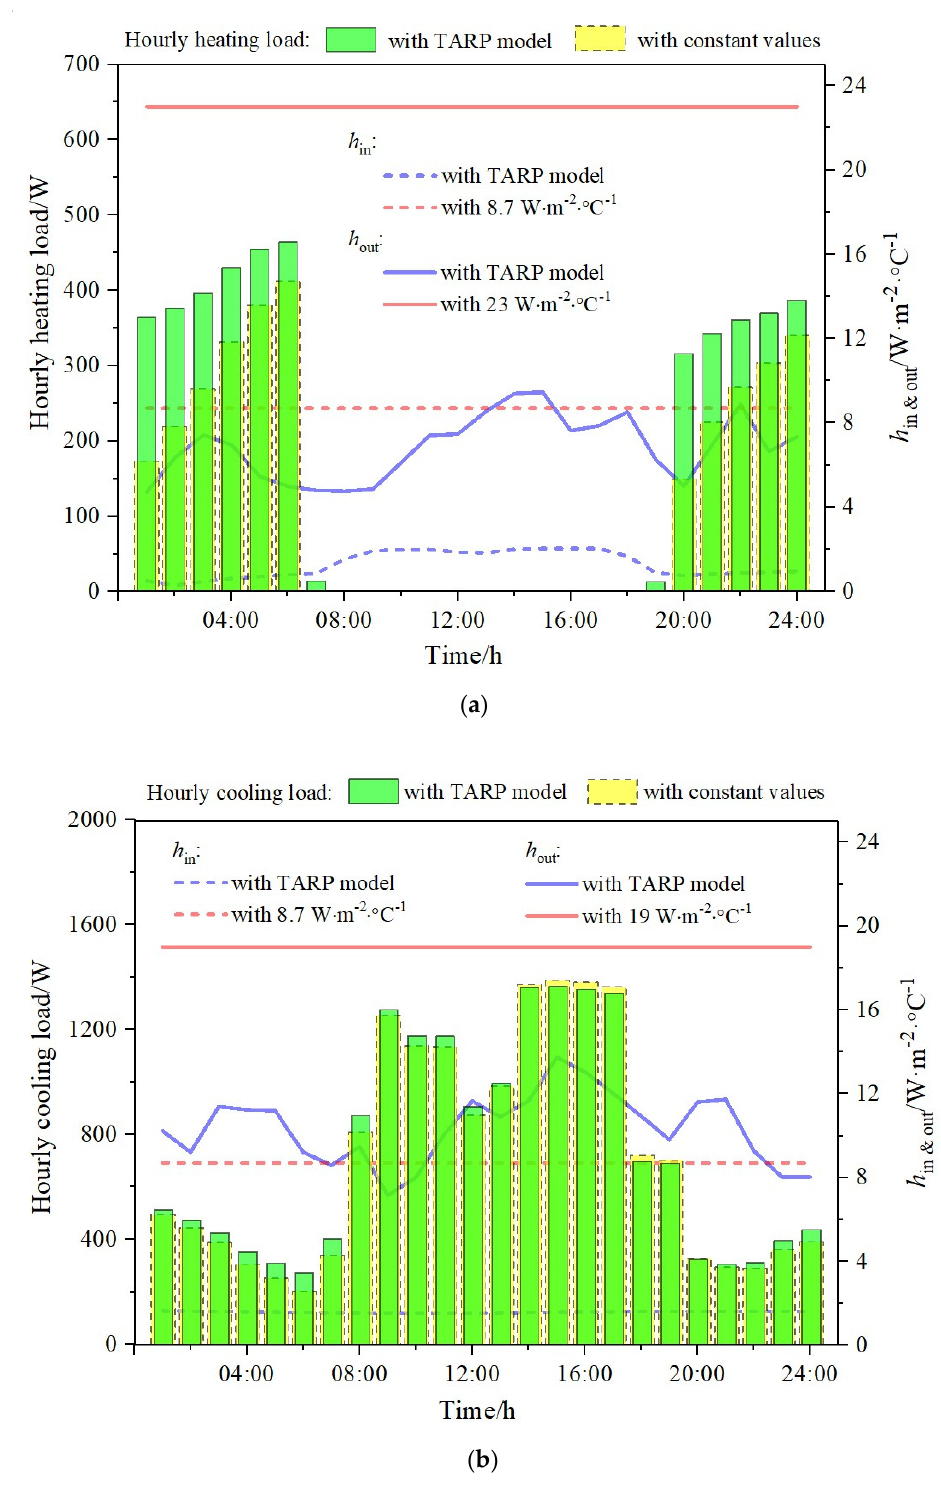
Figure 8. Comparisons of hourly loads with different internal and external SHTCs on a typical day: ( a ) Hourly heating load on a typical day in winter; ( b ) Hourly cooling load on a typical day in sum-